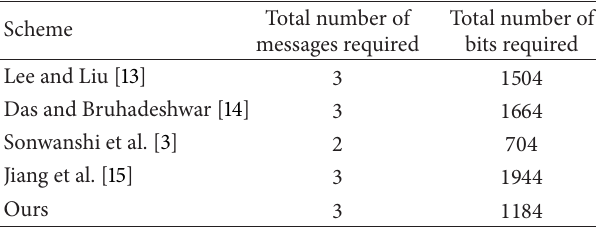
Table 4: Comparison of communication overhead between our scheme and other related schemes during the login and authenti- cation